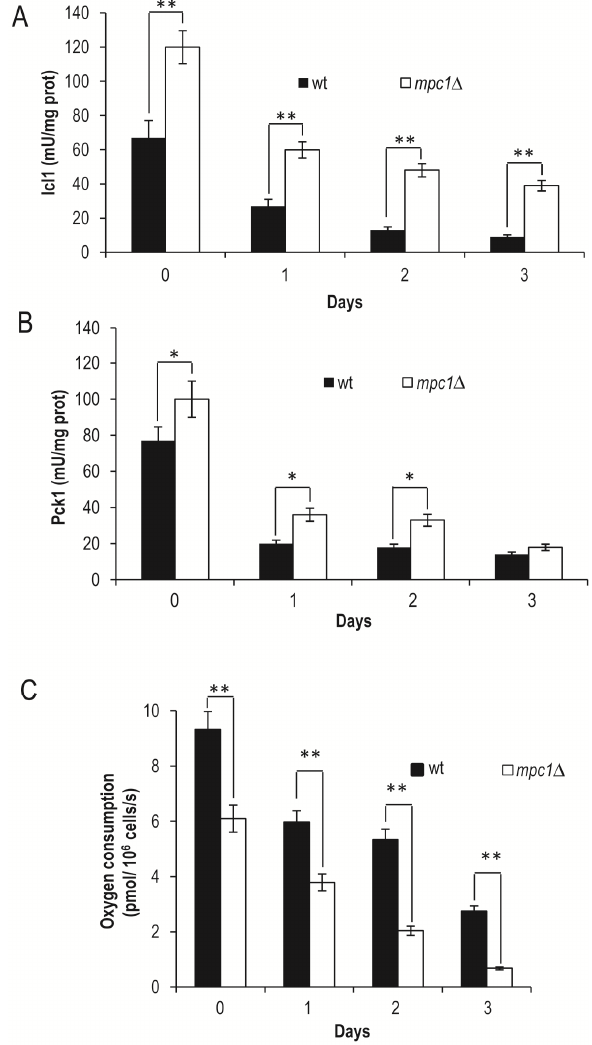
FIGURE 5: MPC1 inactivation increases glyoxylate/gluconeo- genesis and reduces respiration during chronological aging. At the indicated time points Icl1 (A) and Pck1 (B) enzymatic activities of wt and mpc1 Δ mutant cells were measured. In parallel, cellular respiration (C) was also monitored. Day 0, diauxic shift. Data refer to mean values determined in three independent experiments. SD is indicated. * P ≤ 0.05 and ** P ≤